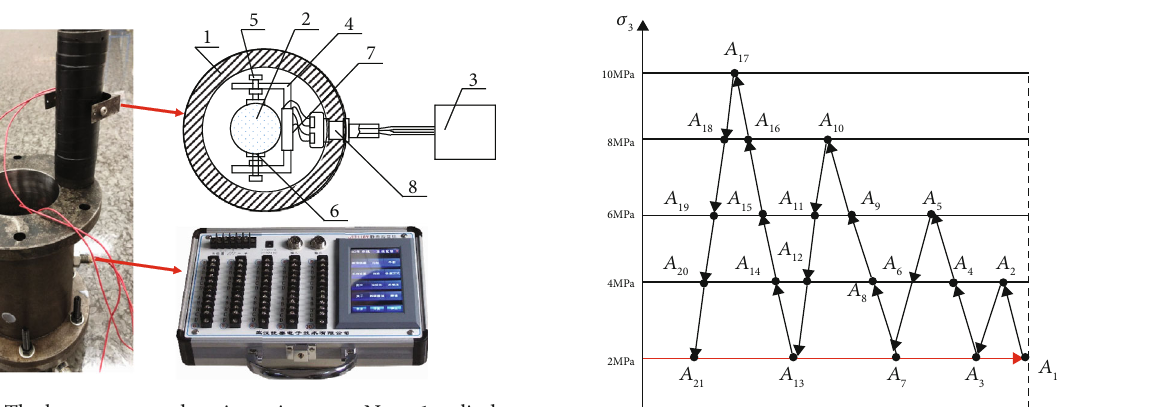
Figure 6: The bow sensor and static strain gauge. Note: 1: cylinder as a three-axis chamber; 2: coal sample; 3: static resistance strain gauge; 4: radial displacement sensor bracket; 5: fastening bolt; 6: clamping piece; 7: strain gauges; 8: hinge pin.